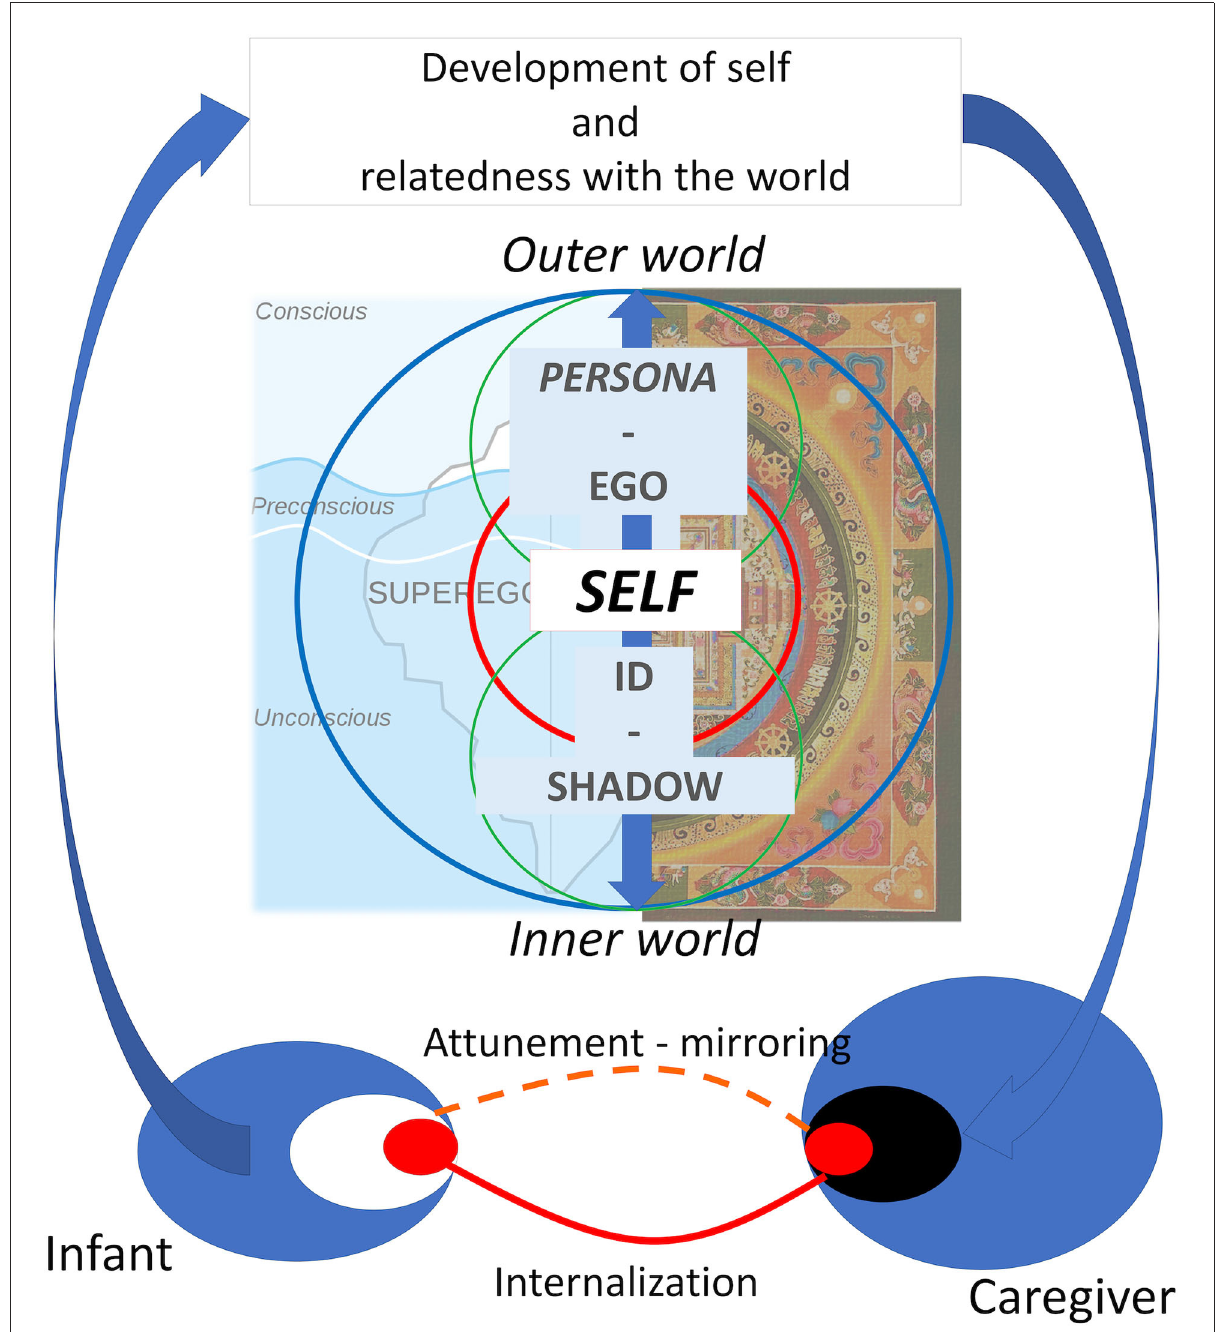
FIGURE1 Integrative conception of self in Jung, Freud, and contemporary relational psychoanalysis. Freud’s view is represented on the left while Jung’s view is on the right of the figure. The bottom of the figure represents the process of self-development through the continuous relational exchange with the caregiver as theorized by contemporary relational